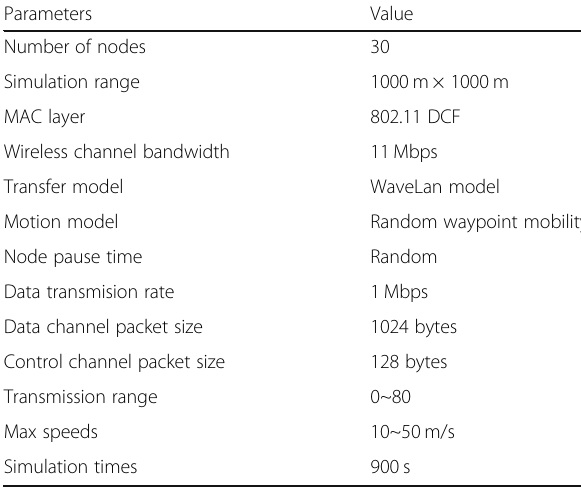
Table 1 Network parameter